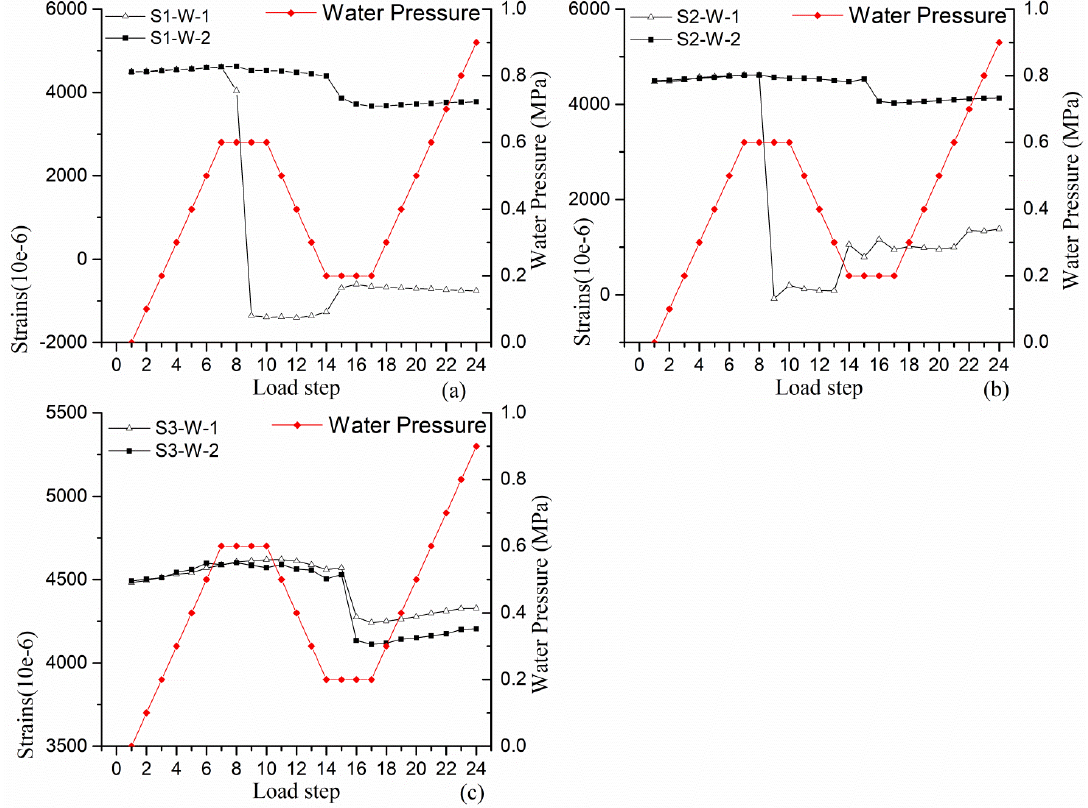
Figure 14. The strain curves of prestressing wires: ( a ) Section 1; ( b ) Section 2; ( c ) Section 3.